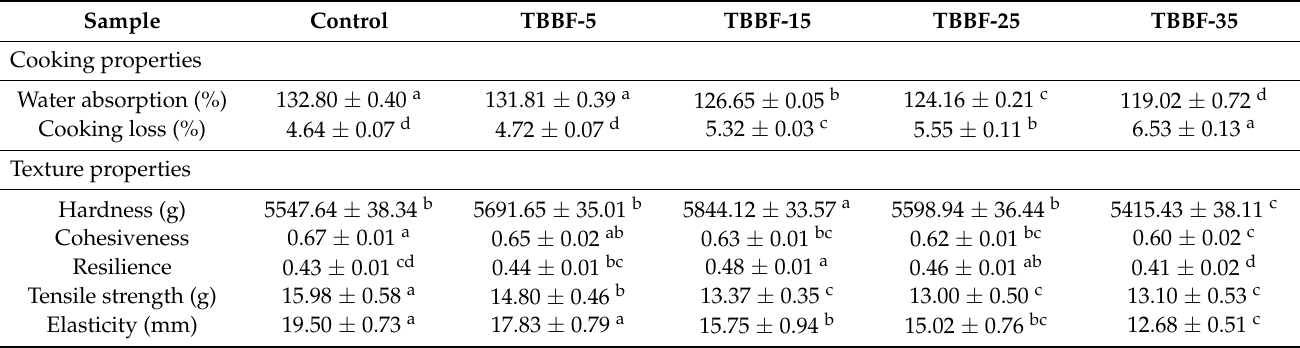
Table 2. Effect of TBBF substitution on the cooking and textural properties of